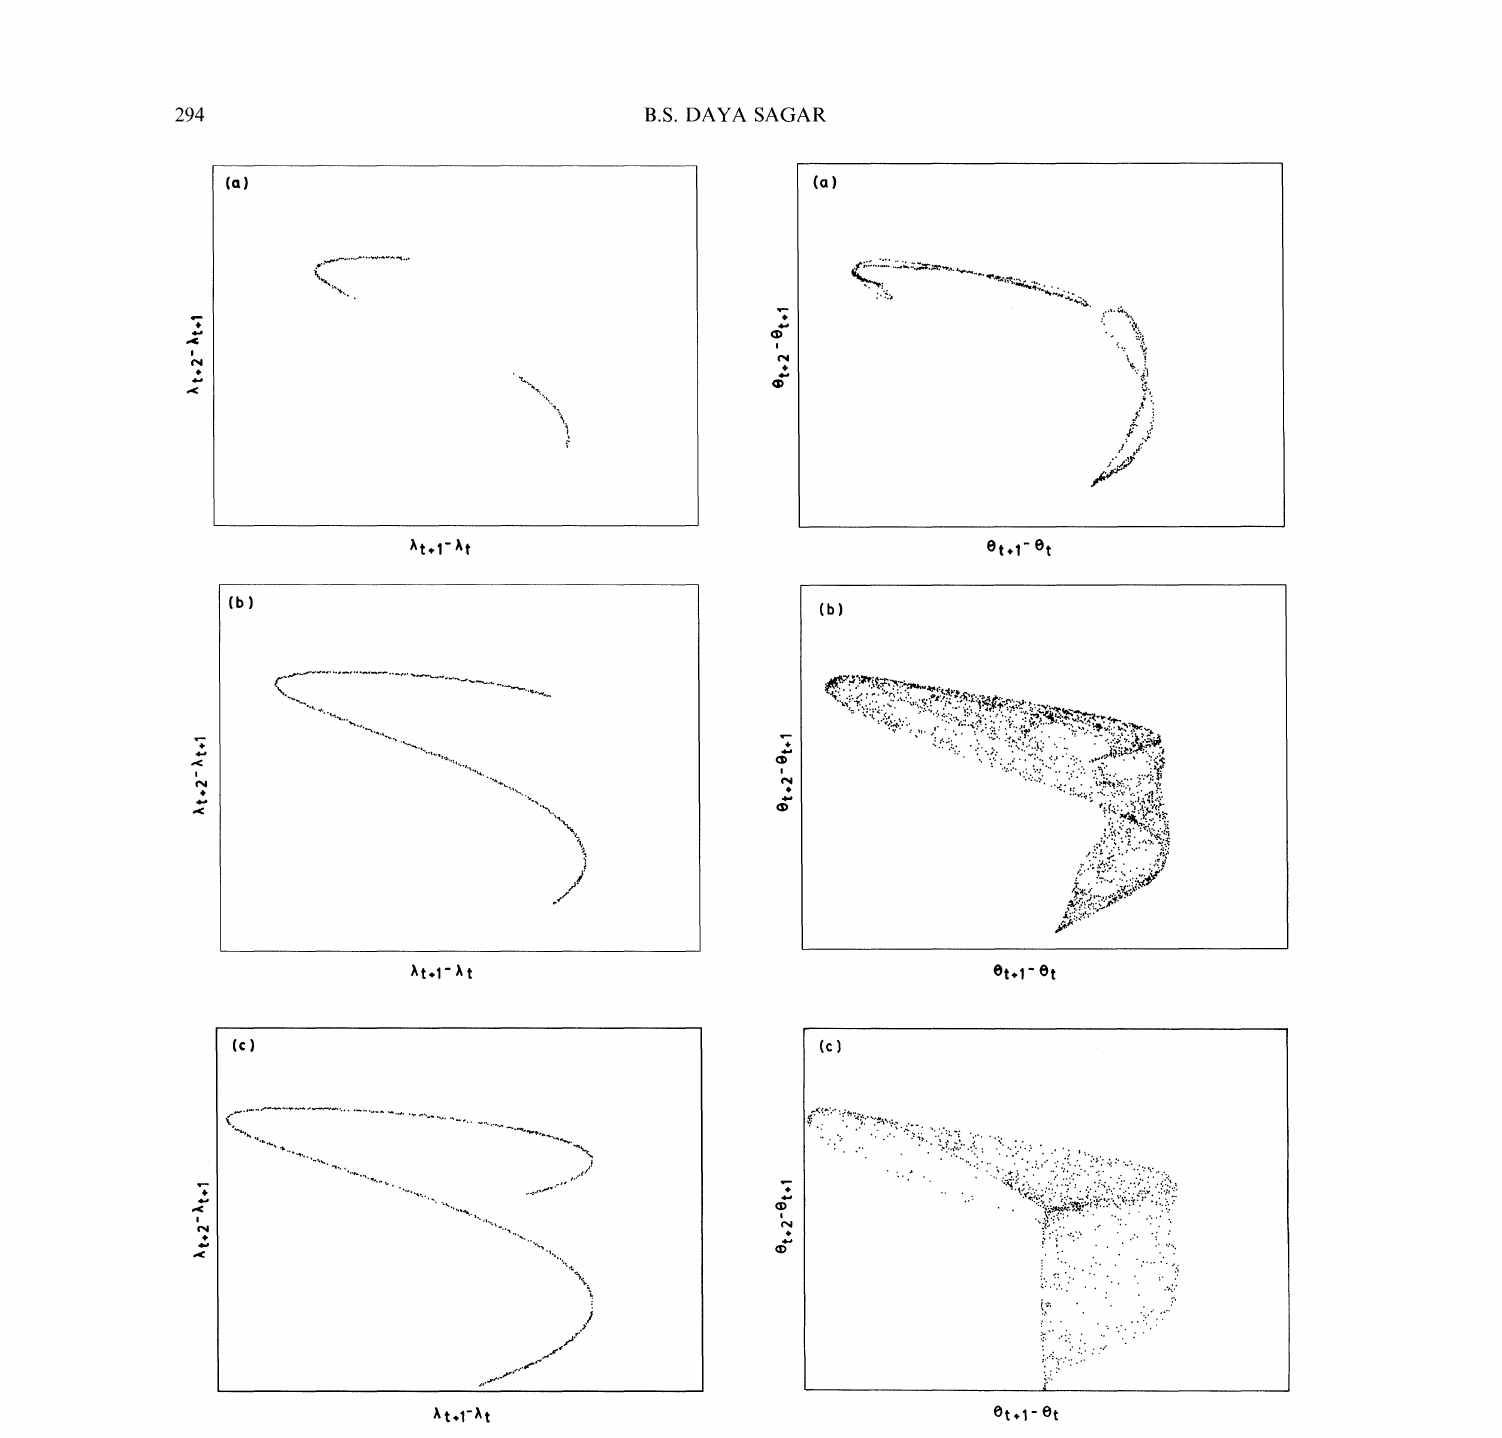
FIGURE 5 Return map of the dynamics of time dependent stress regulatory parameter (),;+l-,t vs ,;+2-)+ 1). The stress modulation control parameter (#) that controls the time dependent stress regulatory parameter, (a) #=0.9, (b) 0.95 and (c) 0.9925. The initial normalized stress parameter ,k; 0.00001.